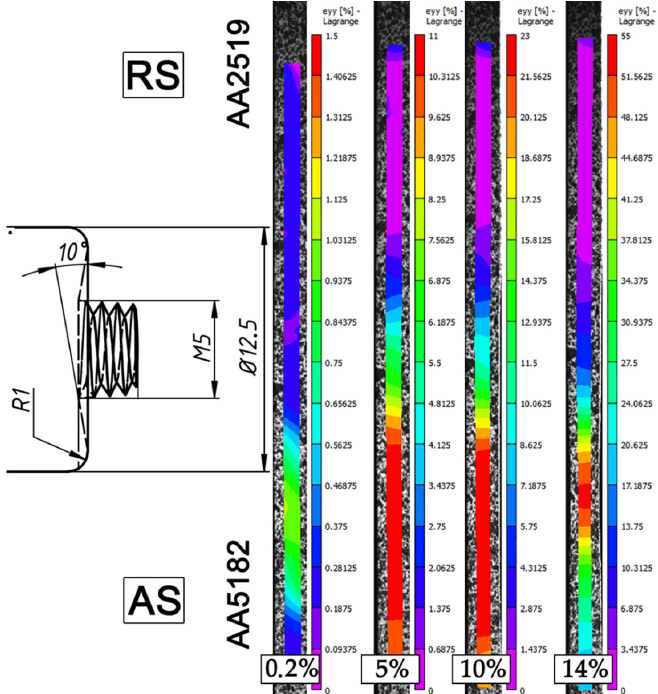
Figure 6. Distribution of local longitudinal strains on the cross-section side of the 500@15 joint, which evolved during transverse tensile tests after total elongation of 0.2%, 5%, 10%, and immediately before failure. For clarity, a tool drawing is added. The tensile direction is vertical.